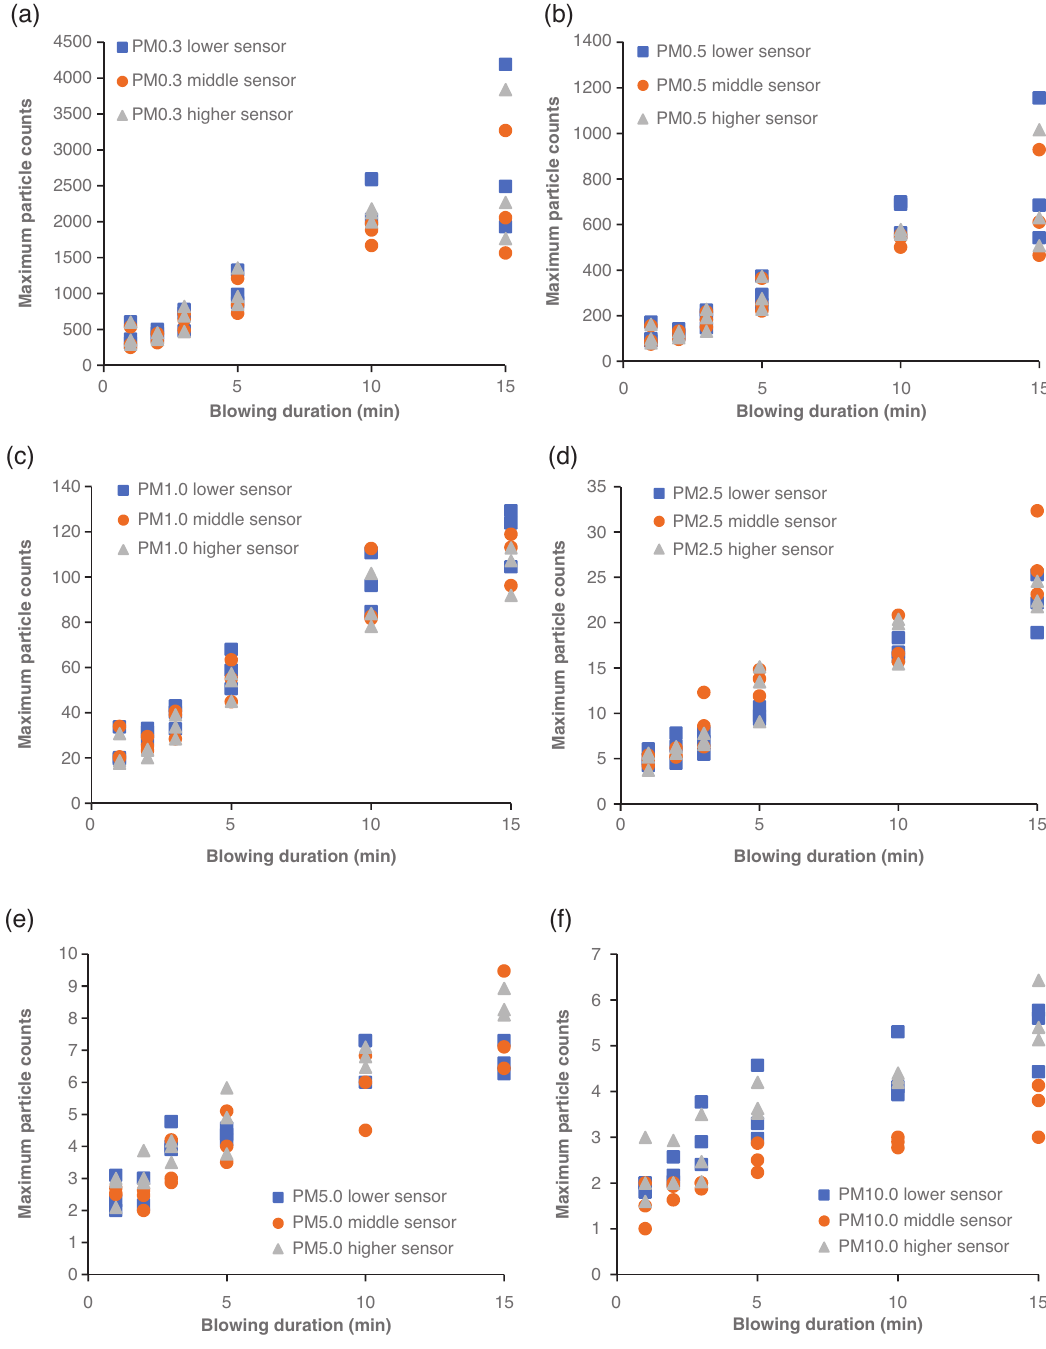
Figure 9 Maximum levels of (a) PM0.3 (b) PM0.5 (c) PM1.0 (d) PM2.5 (e) PM5.0 and (d) PM10.0 with height for the three experimental series. (Source: Authors,